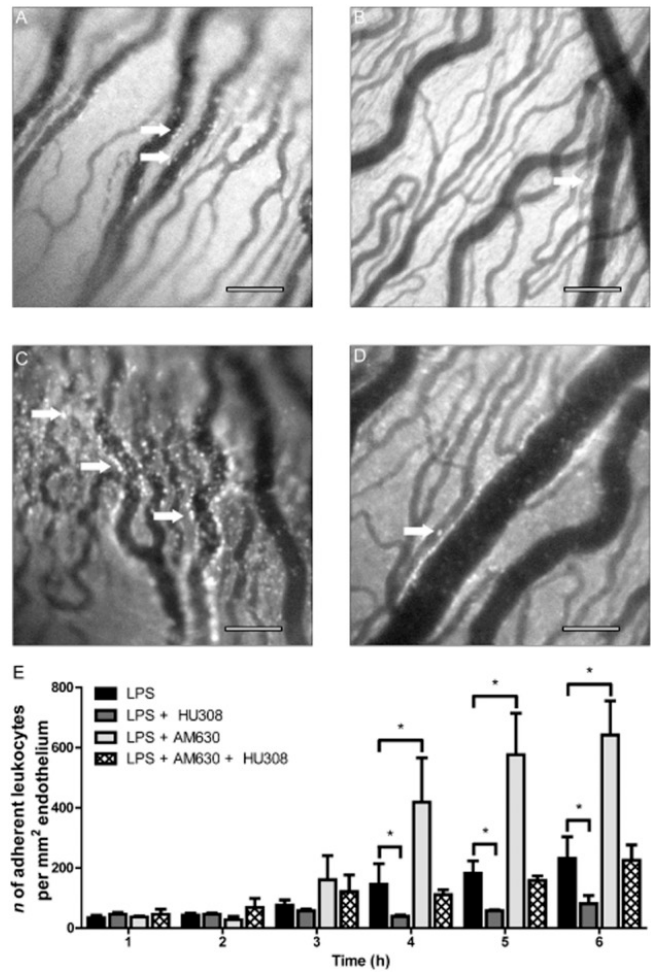
Figure 4. Topical administration of cannabinoid HU308 decreased inflammation in a uveitis mouse model. ( A – D ) Representative intravital microscopy images of iridial microcirculation in rat eyes at 6 h after IVT LPS injection in the following groups: ( A ) LPS injection only; ( B ) LPS + CB2 receptor agonist, HU308 (1.5%, topical); ( C ) LPS + CB2 receptor antagonist, AM630 (2.5 mg·kg − 1, i.v.); and ( D ) LPS + AM630+ HU308. Arrows indicate adherent leukocytes. Scale bar = 100 µ m. ( E ) Bar graph representing the time course for the mean number of adherent leukocytes for the above groups including the following: LPS (n = 15); LPS + HU308 (n = 12); AM630 (n = 8); and AM630 + HU308 (n = 7). Values represent the means ± SEM. * p < 0.05 compared with the LPS group. Reproduced from Toguri et al.